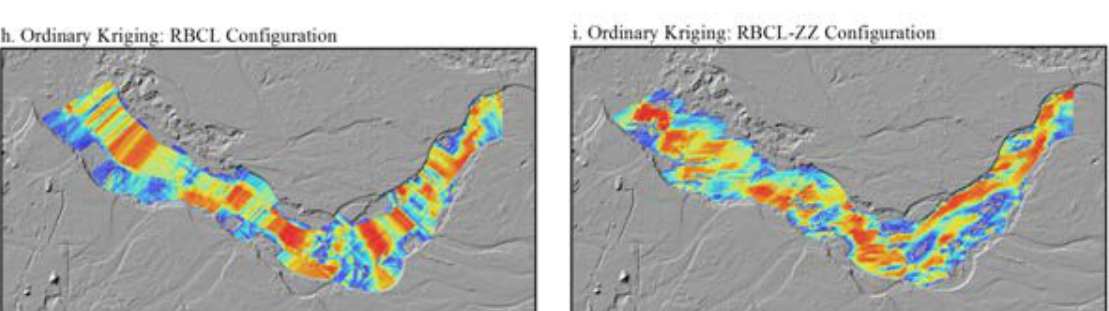
Figure 7. Maximum flood depths simulated by the 2D hydraulic model using the original DTM and 8 bed-integrated